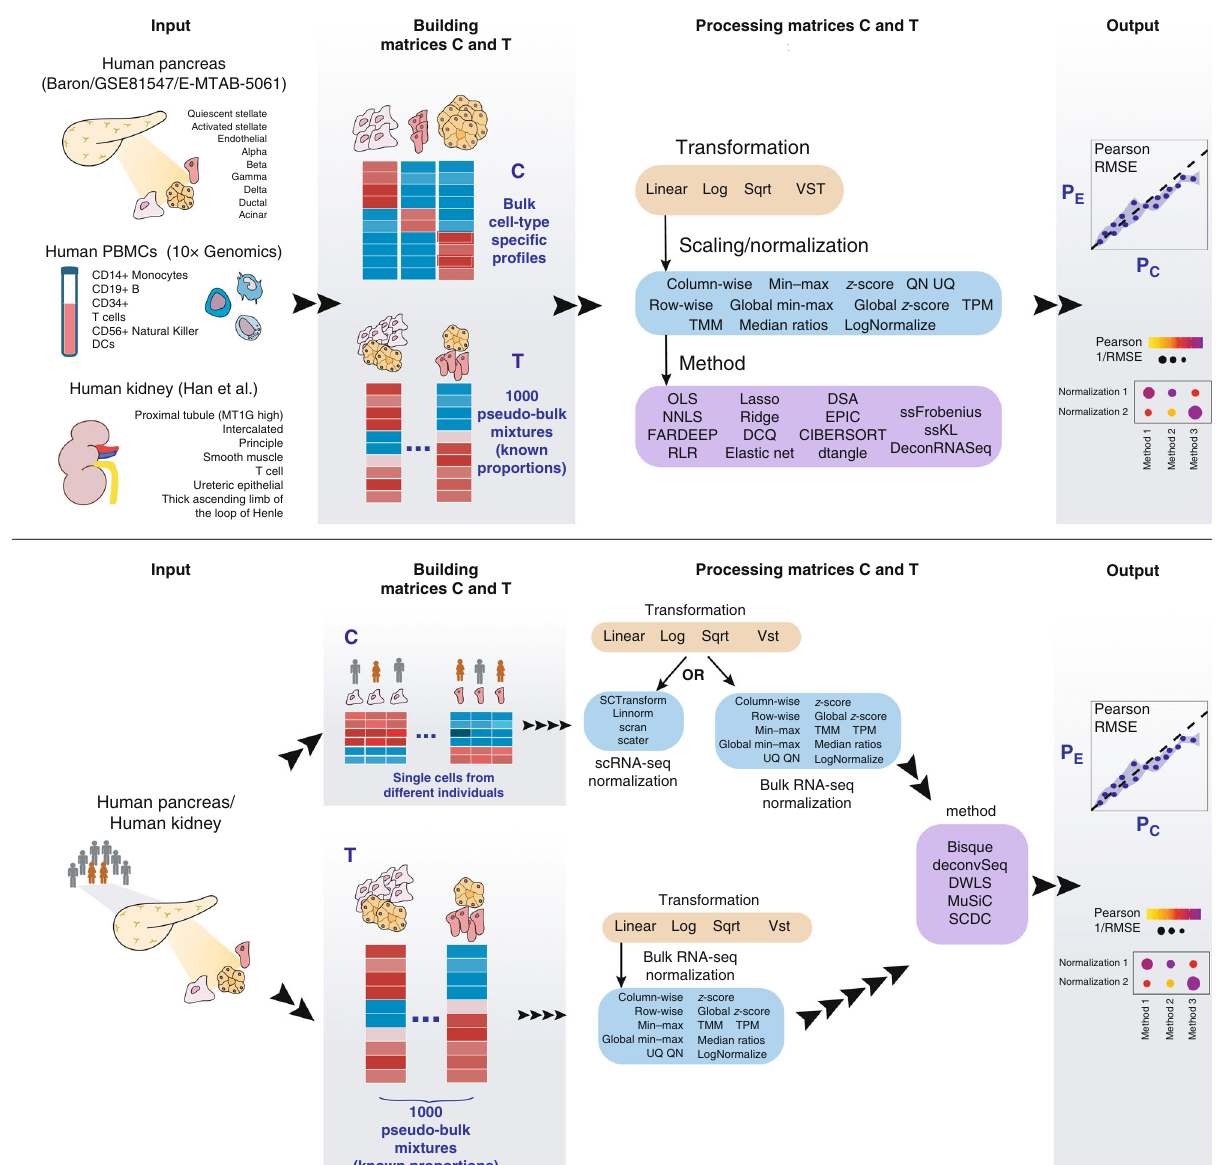
Fig. 1 Schematic representation of the benchmarking study. Top panel: work fl ow for bulk deconvolution methods. Bottom panel: work fl ow for deconvolution methods using scRNA-seq data as reference. In both cases the deconvolution performance is assessed by means of Pearson correlation and root-mean-square error (RMSE). PBMCs: peripheral blood mononuclear cells, log: logarithmic, sqrt: square-root, VST: variance stabilization transformation, PE: expected proportions, Pc: computed